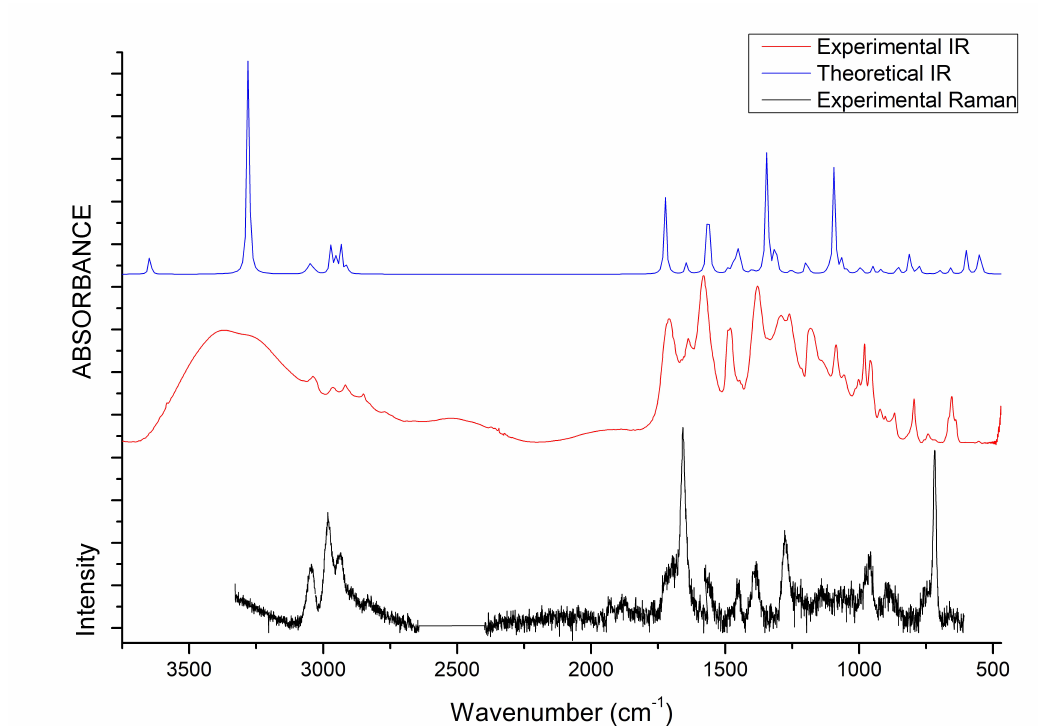
Figure 8. IR and Raman spectra of [Ch][H-fumarate] liquid. B3LYP values are scaled for 0.96